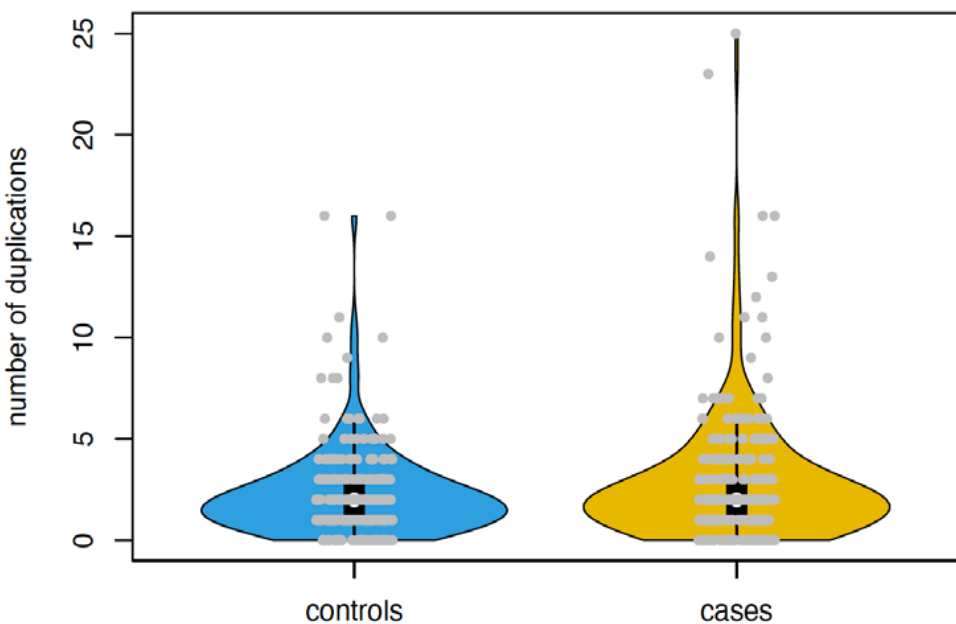
Figure 2. Differences in CNVs between cases and controls. Violin plot for numbers of called dupli- cations between controls and cases. The difference remains significant after exclusion of two cases with more than 20 duplications ( p = 0.03 based on 10,000 permutations).